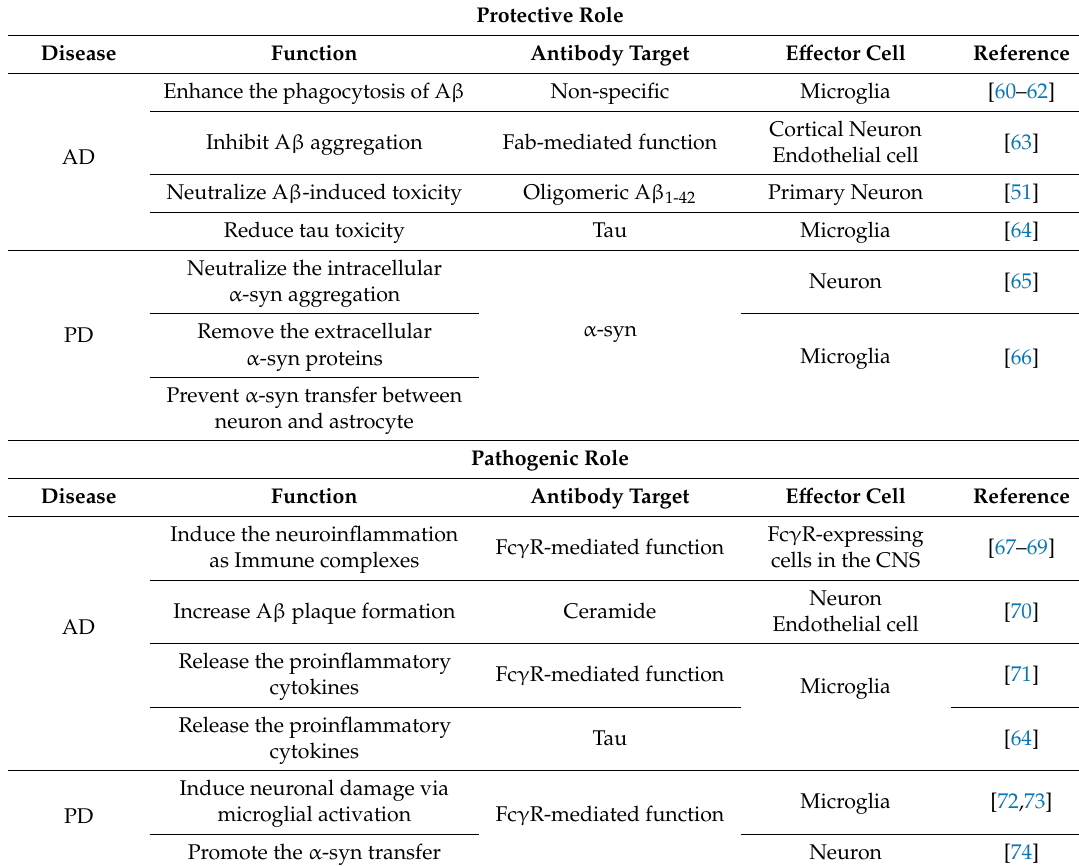
Table 1. The potential roles of autoantibodies in neuronal degenerative